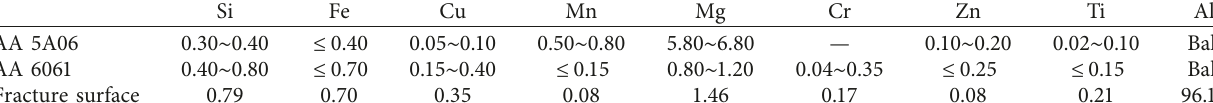
Table 1: Chemical composition of AA 5A06, AA 6061, and the fracture surface of the welded specimen (wt.%).